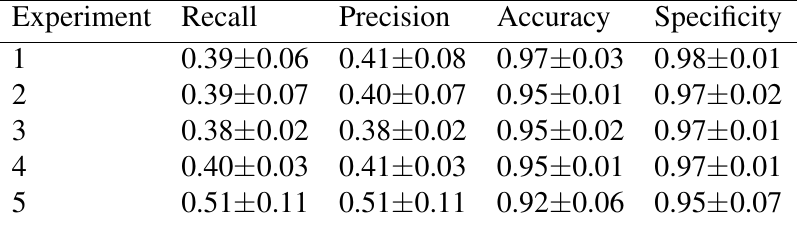
Table 3: Efficiency of our method at 8 ˚A of distance threshold ( (cid:22) (cid:6) (cid:27)